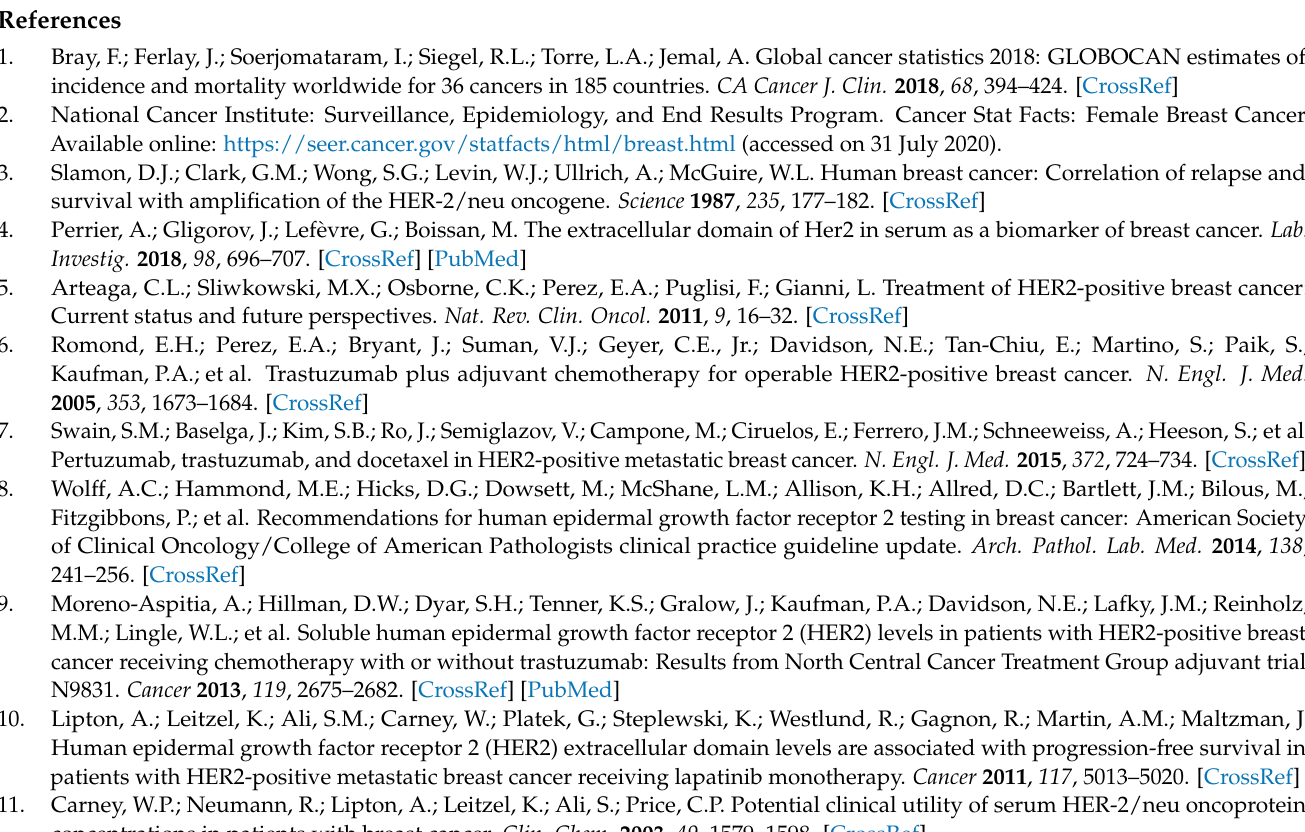
DFS (b), OS (c), and ORR (d). Figure S2. Subgroup analysis of PFS according to different treatment modalities (a), cut-off values (b) and ethnicity (c). Figure S3. Subgroup analysis of DFS according to different treatment modalities (a), cut-off values (b) and ethnicity (c). Figure S4. Subgroup analysis of OS according to different treatment modalities (a), cut-off values (b), disease status (c) and ethnicity (d). Figure S5. Subgroup analysis of ORR according to different treatment modalities (a), cut-off values (b) and ethnicity (c). Figure S6. Funnel plot to detect publication bias for PFS (a), DFS (b), OS (c), and ORR (d). Figure S7. Trim and fill analysis for pooled HR of